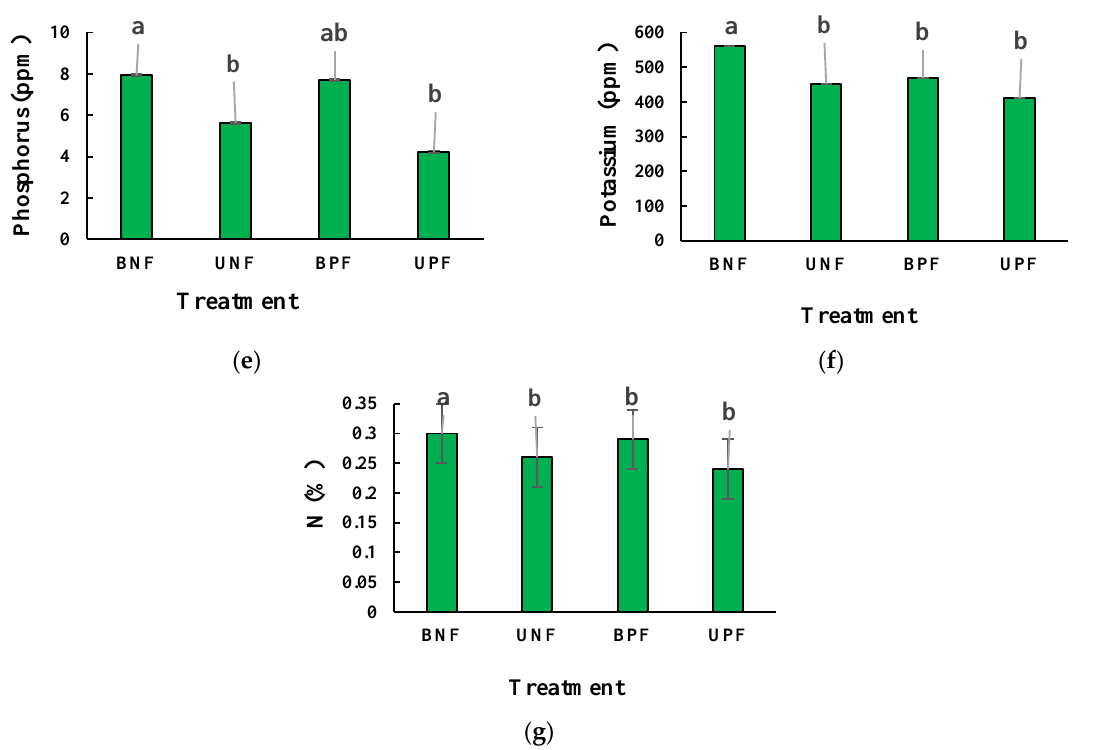
Figure 5. Comparison of the average chemical properties under different plot types ( a – g ); BNF; Burned Natural Forest, UNF: Unburnt Natural Forest, BPF: Burned Plantation Forest, and UPF: Unburnt Plantation Forest.